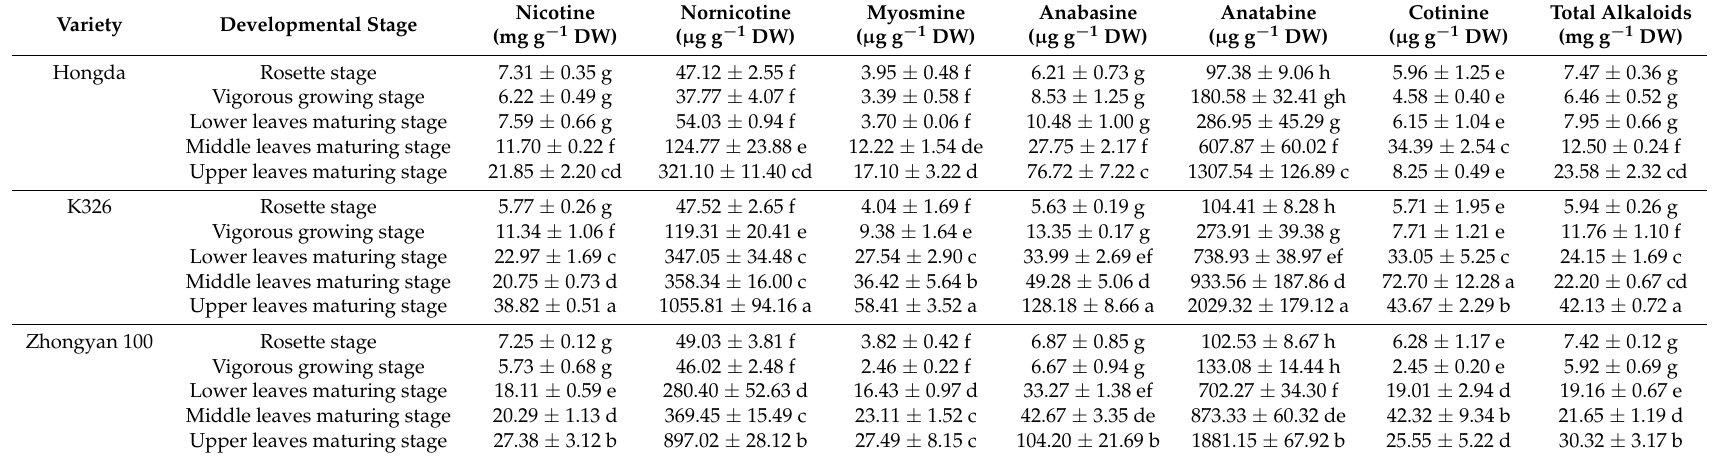
Table 3. Alkaloid composition and contents in Nicotiana tabacum leaves among different varieties and developmental stages.